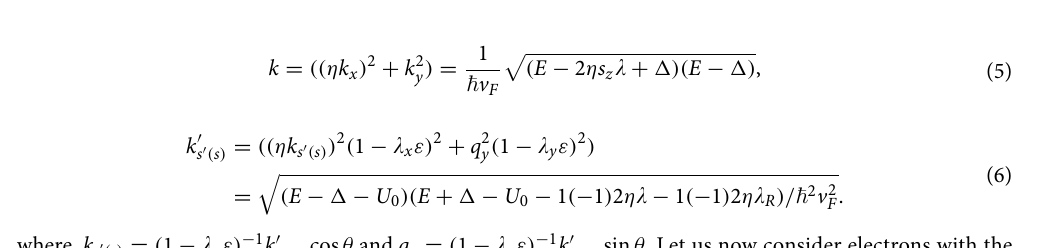
b = 5 and k F w = 3. For ( a ) two barrier, ( b ) four barriers, and ( c ) eight barriers 0 0